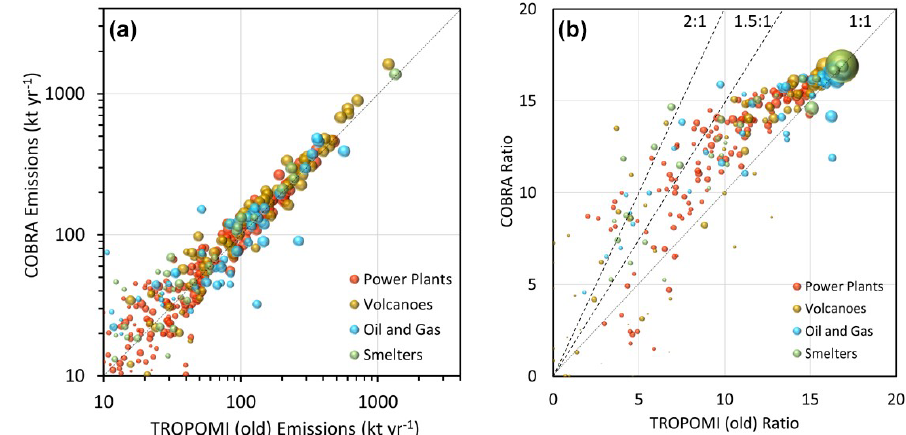
Figure 7. (a) Estimated SO 2 emissions from TROPOMI, based on the COBRA and DOAS algorithms analysed for power plants, volcanoes, oil and gas industries, and smelter sources. (b) Ratios of the estimated emissions and the corresponding uncertainties. The size of the marker is proportional to the average of COBRA and DOAS (a) ratios between emission value to its corresponding uncertainty and (b) estimated SO 2